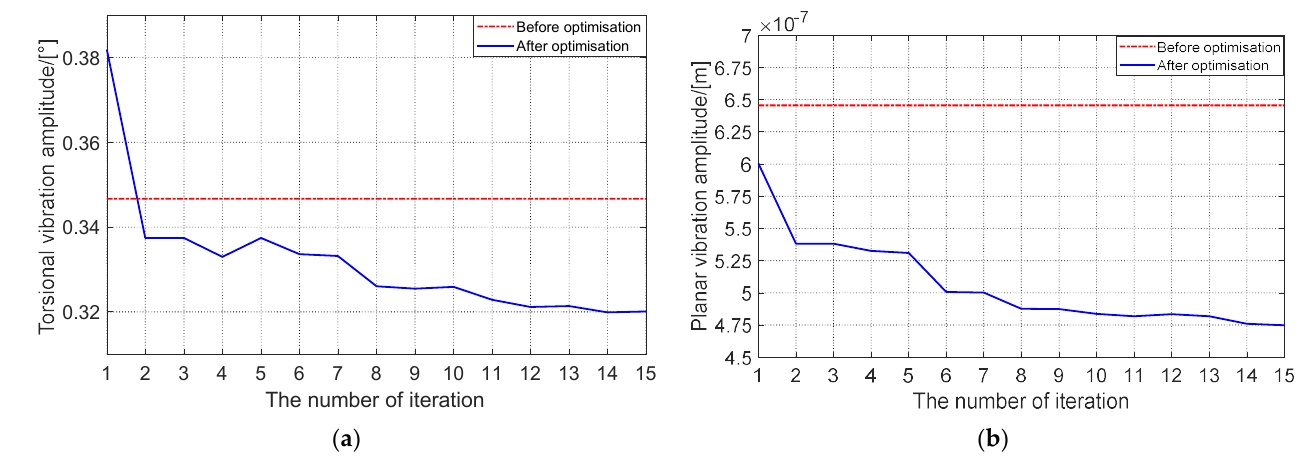
Figure 12. Results of iteration calculation: ( a ) torsional vibration of the main reducer; ( b ) planar vibration of the main reducer.